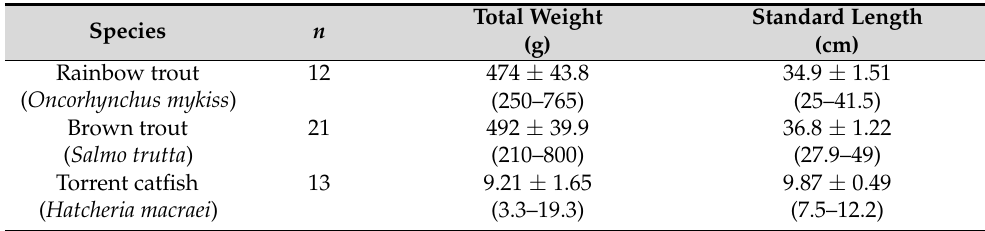
Table 3. Morphometric description of fish collected from Mendoza River.